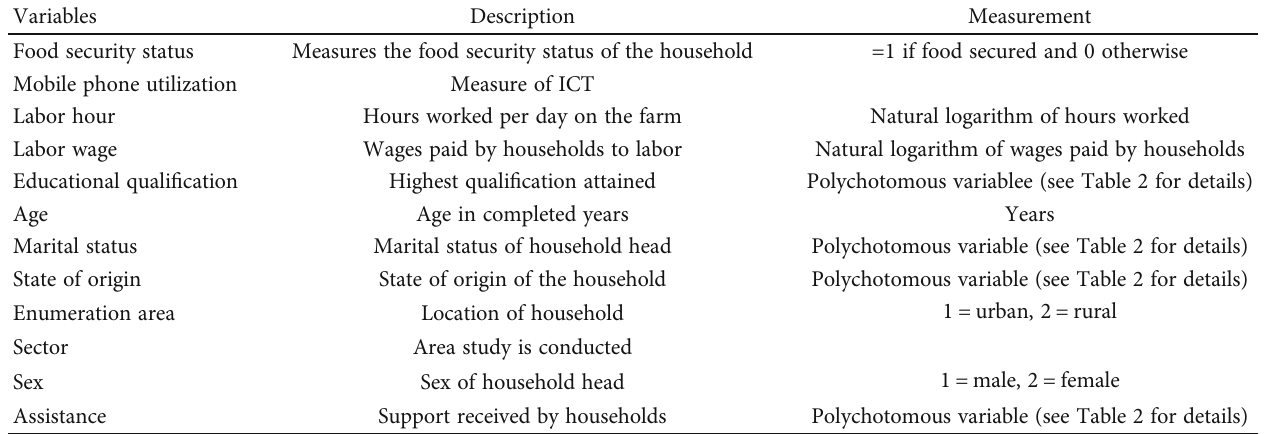
Table 1: Variable description and